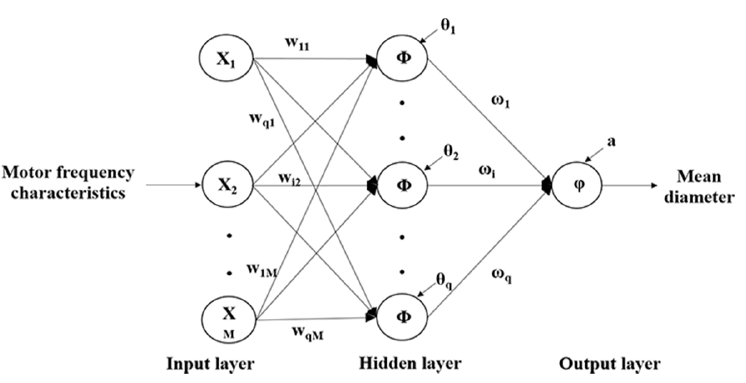
Figure 6. Topological structure of BP neural network model.